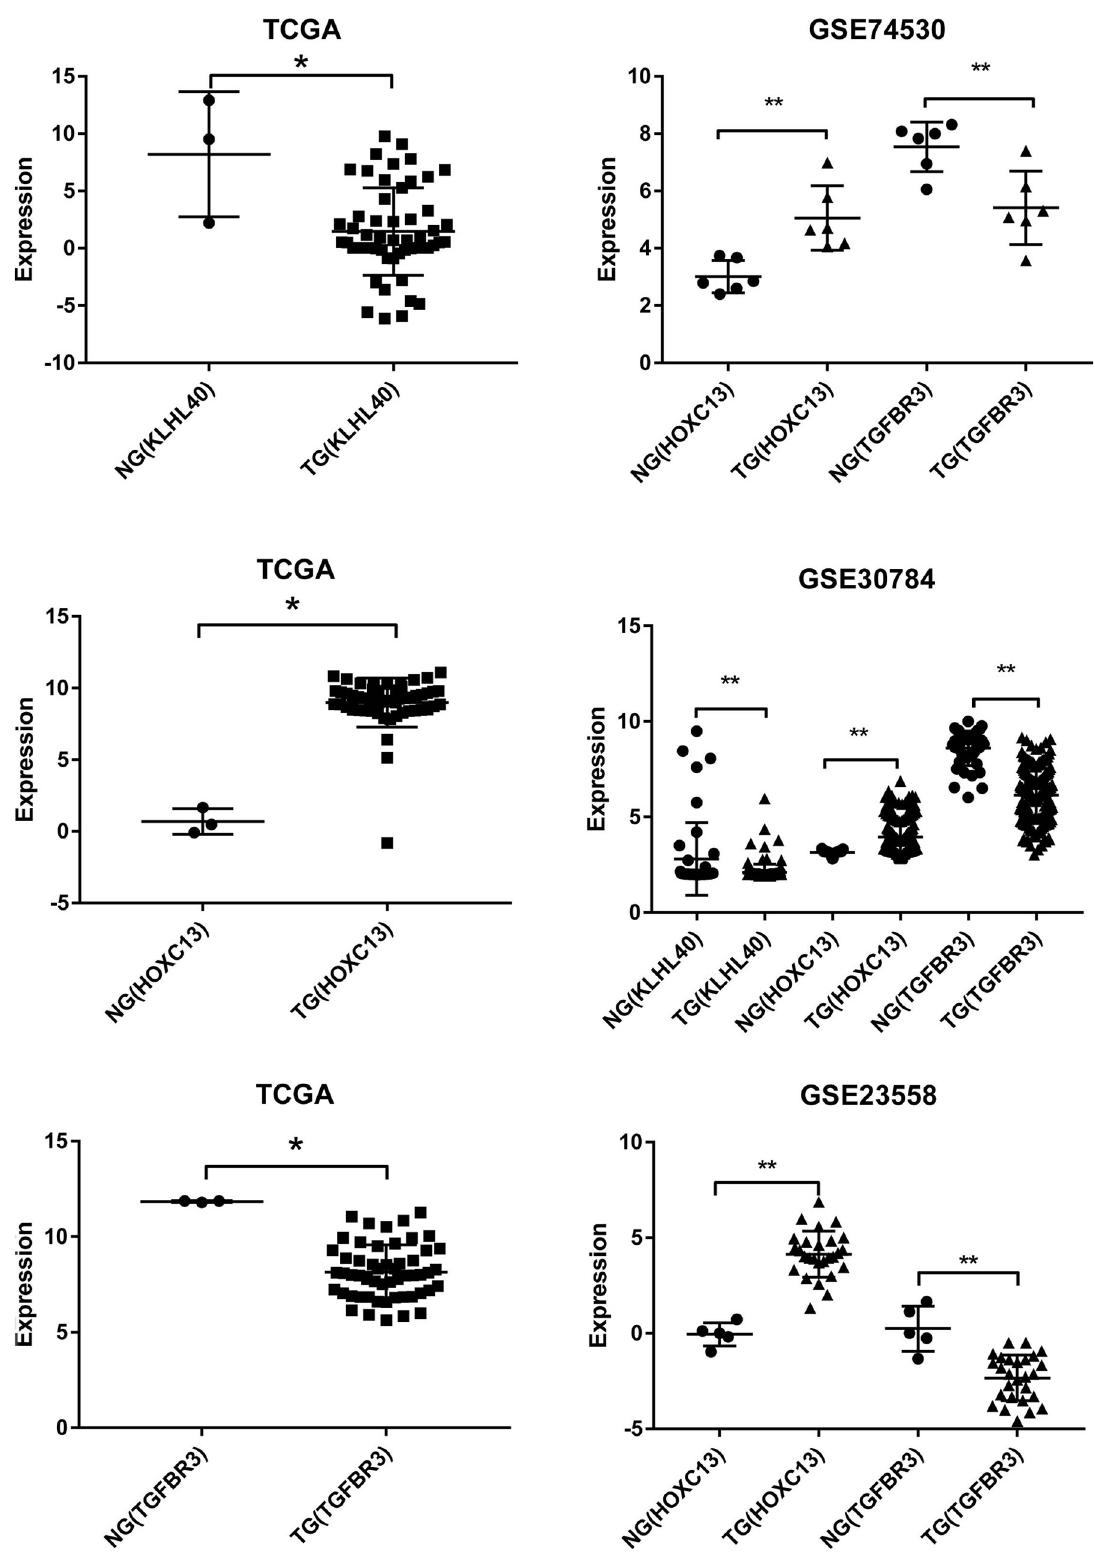
Fig 6. (A, B, C) The expression of 3 key mRNAs in TCGA. (D, E, F) The expression verification of 3 GEO databases.